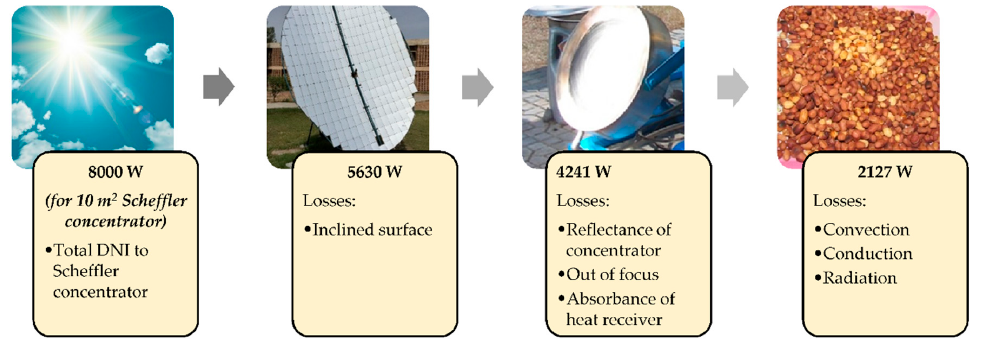
Figure 9. Energy distribution and losses for groundnut roasting (dark condition) in CSR with average incoming DNI of 800 Wm − 2.